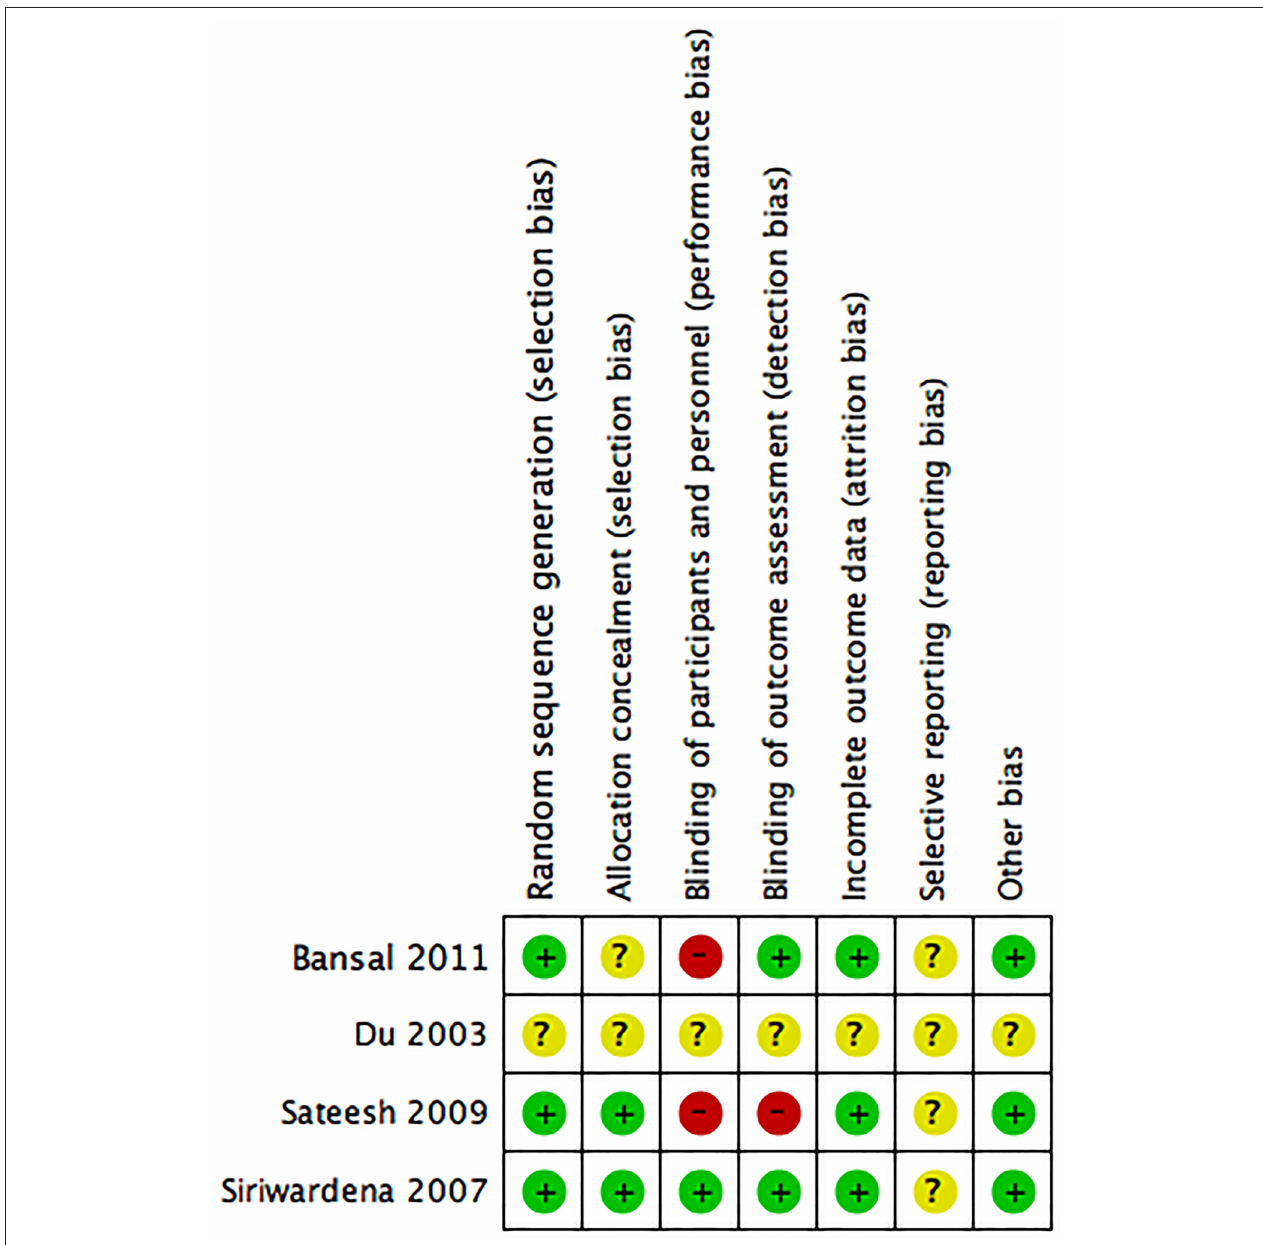
FIGURE 2 | Risk of bias assessment of four clinical trials included in the meta-analysis.